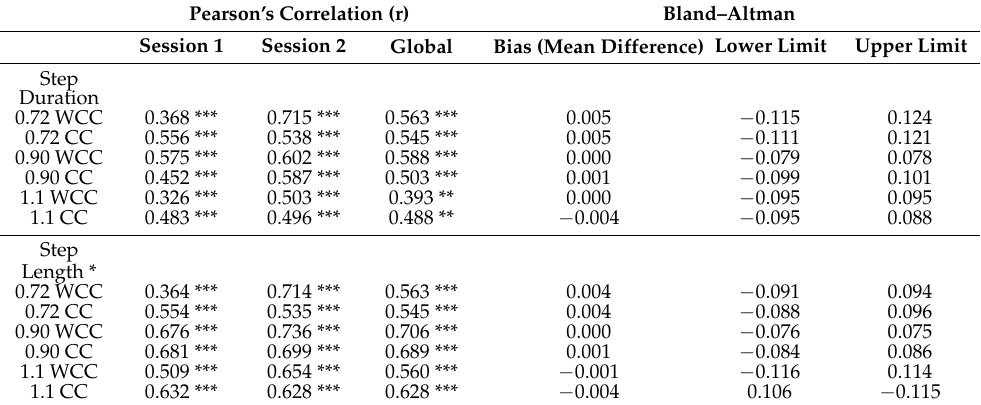
Table 4. Concurrent validity of the spatiotemporal parameters between the glasses and the optoelec- tronic